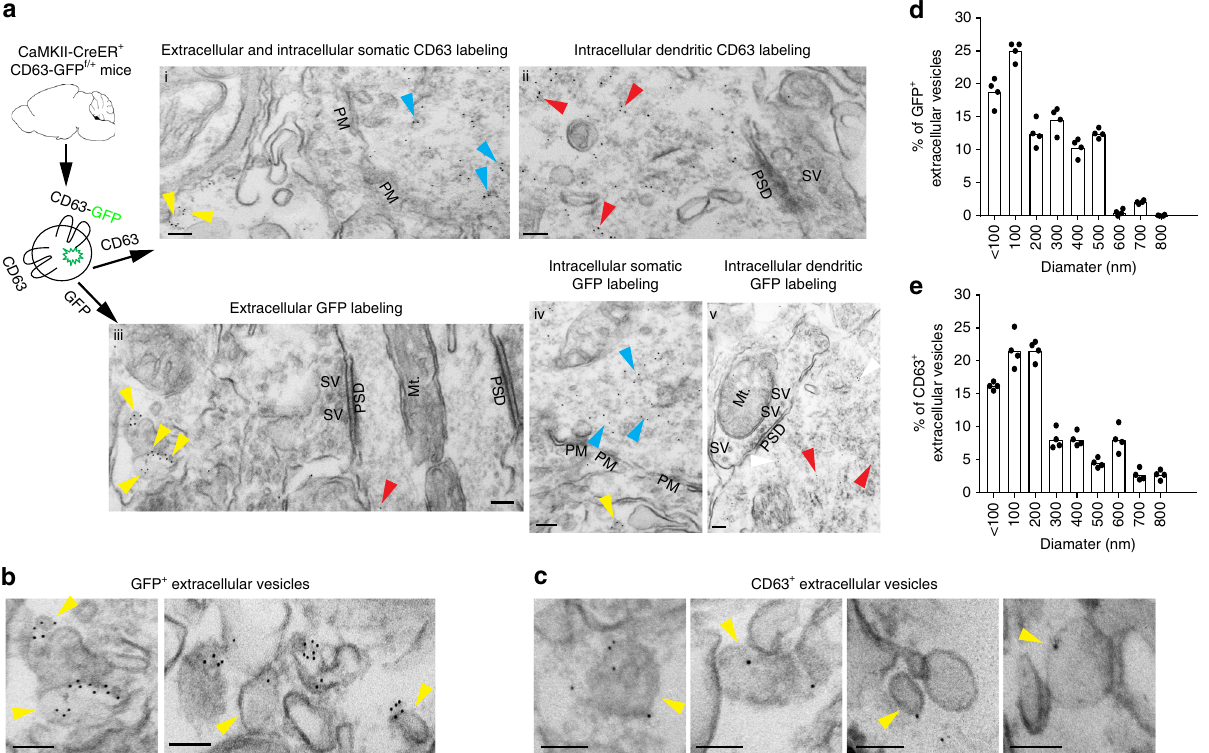
Fig. 4 In situ localization of neuronal ILVs and exosomes revealed by immuno-EM. a Representative immuno-EM of CD63 and GFP, respectively, in the brain of CaMKII-CreER + CD63 f/ + mice. Immunogold labeling of CD63 and GFP were separately performed on the same CaMKII-CreER + CD63 f/ + mouse brain. Subpanels i: extracellular and intracellular somatic CD63 labeling; ii: intracellular dendritic CD63 labeling; iii: extracellular GFP labeling; iv: intracellular somatic GFP labeling; v: intracellular dendritic GFP labeling; Blue arrows: intracellularly localized CD63 or GFP puncta; Yellow arrows: extracellularly localized CD63 or GFP puncta; Red arrows: Dendritically localized CD63 or GFP puncta; PM: plasma membrane; SV: synaptic vesicles; PSD: post-synaptic density; Mt: mitochondria; Scale bar = 100 nm. Representative GFP + ( b ) or CD63 + ( c ) extracellular vesicles from CaMKII-CreER + CD63 f/ + brain sections (cortex and hippocampus). Yellow arrows: extracellularly localized CD63 + or GFP + vesicles; Scale bar: 100 nm; Quanti fi cation of extracellular GFP + ( d ) or CD63 + ( e ) vesicles from CaMKII-CreER + CD63 f/ + brain sections. The anti-CD63 antibody speci fi cally recognizing human CD63 was used. n = 120 – 150 images from four mice; mean value from each mouse quanti fi cation was presented as individual data